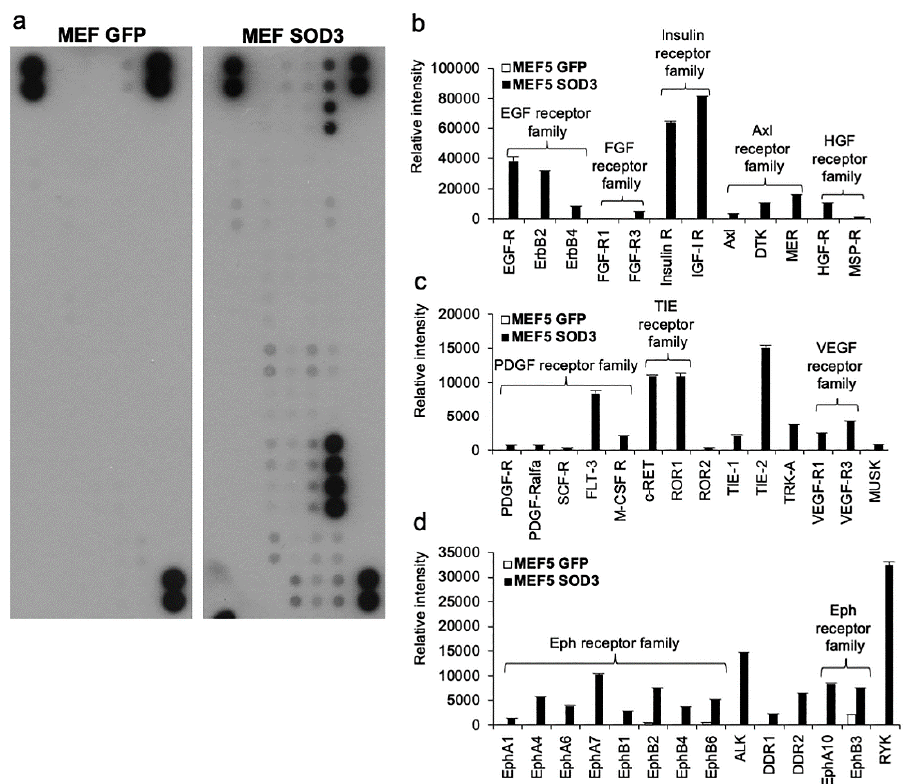
Figure 3. Tyrosine kinase receptor activation analysis. ( a ). MEF GFP and MEF SOD3 protoarray membranes. ( b–d ). Intensity measurements for positive signals in protoarray membranes. The analysis demonstrated EGF, insulin, AXL, HGF, PDGF, TIE, VEGF, and Eph receptor family activation by